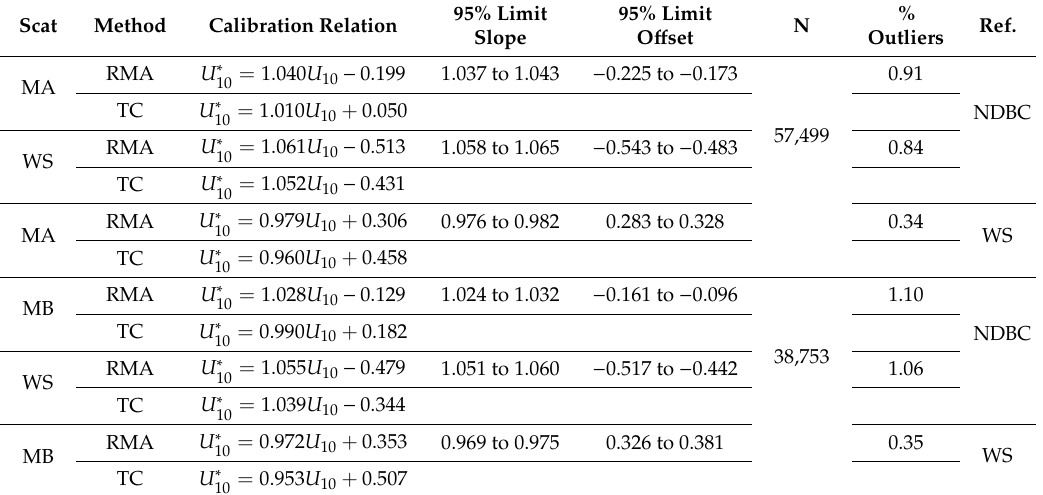
Table 5. Comparison of calibration relations obtained from RMA regression and triple collocation (TC). MA, MB, and WS are abbreviated forms of METOP-A, METOP-B, and WINDSAT, respectively. U ∗ the calibrated value and U 10 is the uncalibrated data. Also shown are the confidence limits on the RMA regression, number of points, N , and the percentage of outliers from the robust regression. Scat